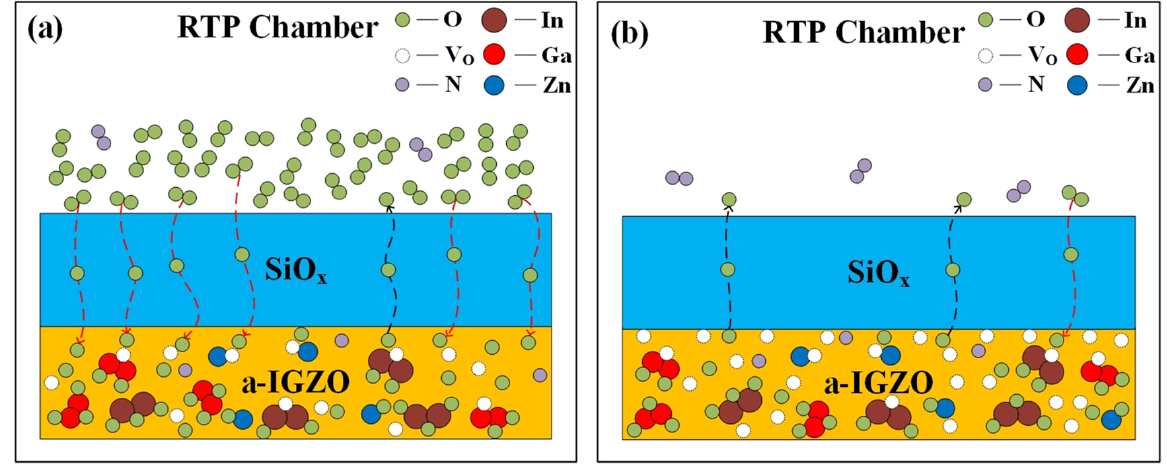
Figure 7. Schematic diagrams of the dynamic processes during the post-annealing treatments at 300 °C in ( a ) O 2 (or air) and ( b ) vacuum (or N 2 ).